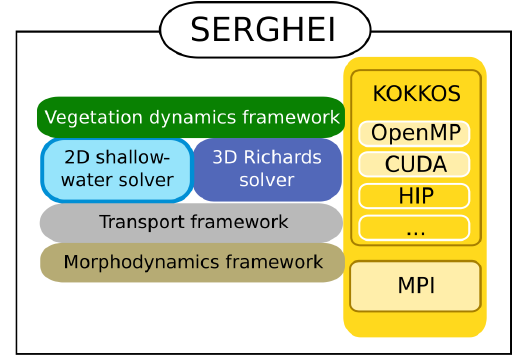
Figure 1. A conceptual framework of